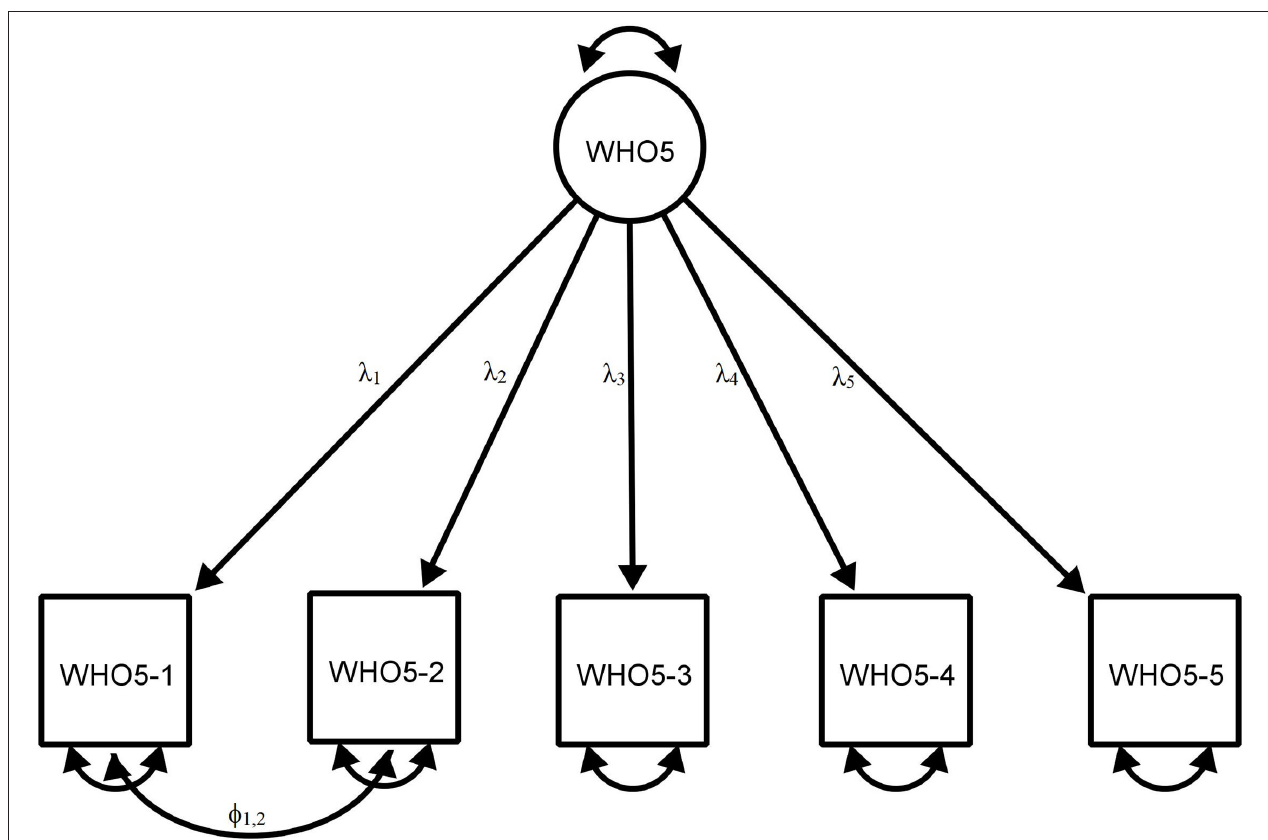
FIGURE 1 | Estimated model of the 5-item WHO Well-Being Index.